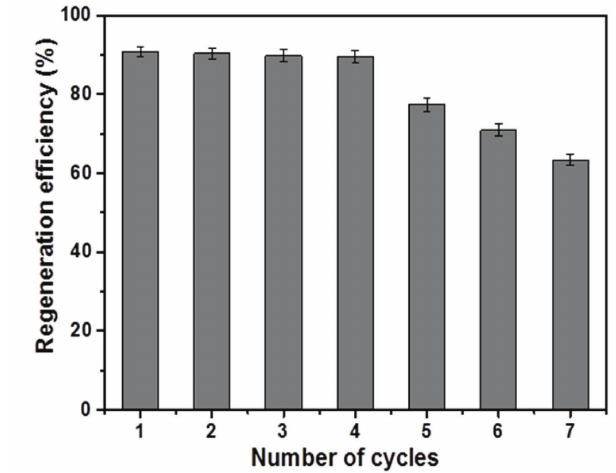
Fig. 9 – Regeneration efficiency of